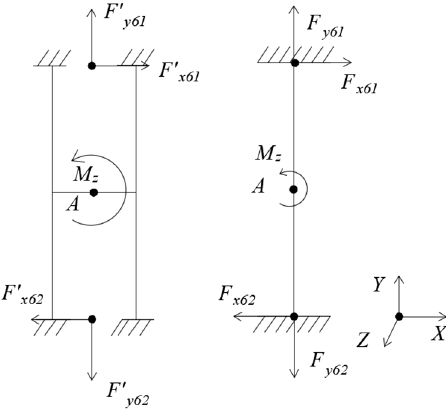
Figure 8. Mechanical models of floating beam and H-beam under M z.